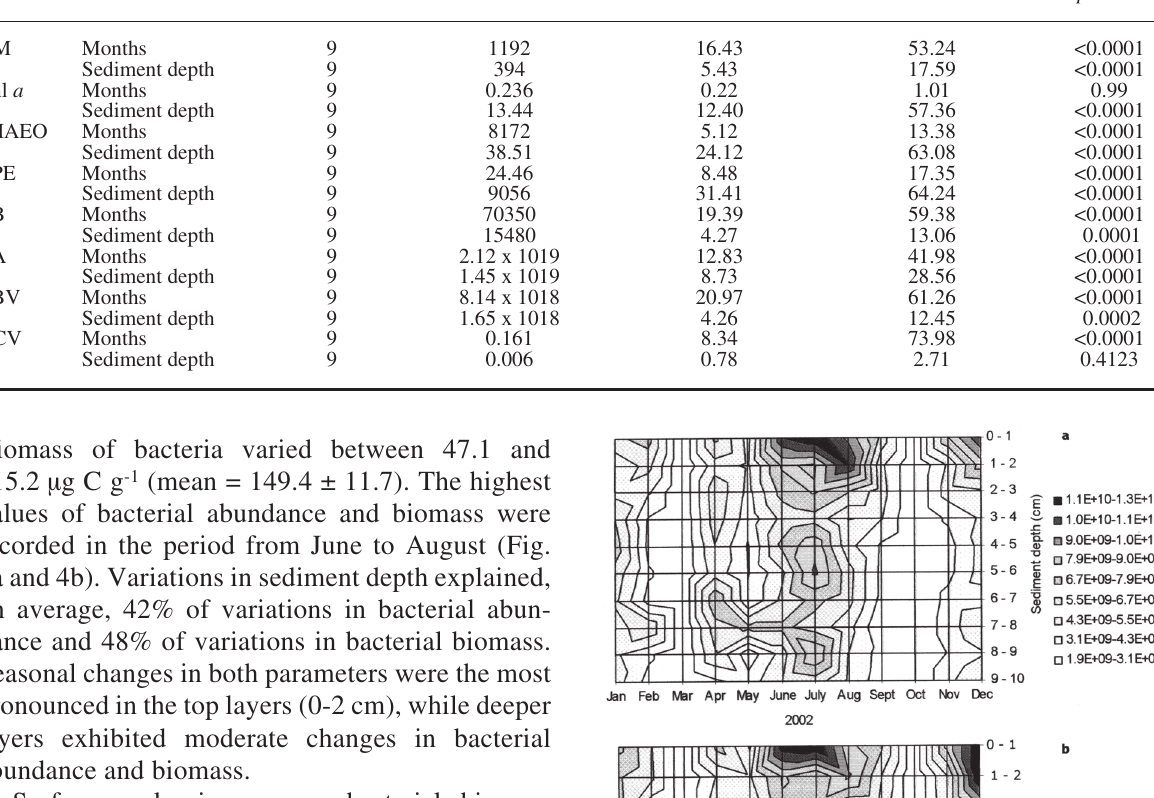
Table 1. – results of two-way (anova) comparing the effect of sediment depth and sampling period on the values of investigated param- eters (oM, organic matter; chl a , chlorophyll a ; PHaeo, phaeopigments; cPe, chloroplastic pigment equivalents; BB, bacterial biomass; Ba, bacterial abundance; BBv, bacterial biovolume; acv, average cell volume; d.f., degrees of freedom; Ms, mean square; f, ratio of between-group variation divided by within-group variation). variable